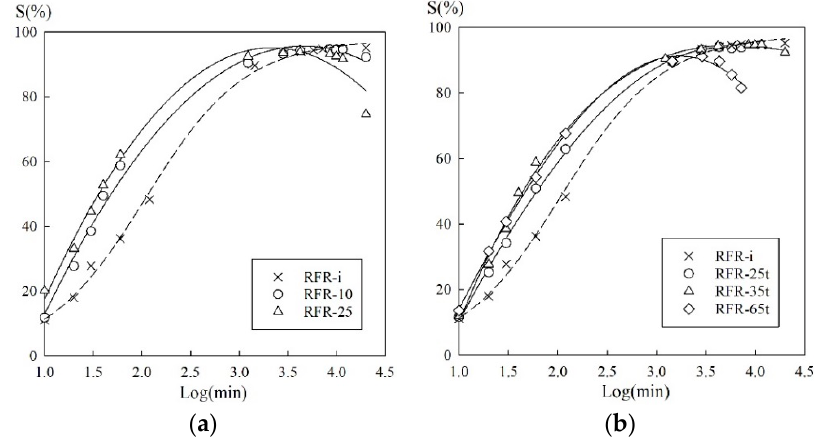
Figure 2. Kinetic curves of Cs-137 sorption in semi-logarithmic coordinates; ( a )—samples obtained via the first route; ( b )—samples obtained via the second route. Table 1. D i and t 1/2 coefficients calculated using Boyd’s equation.